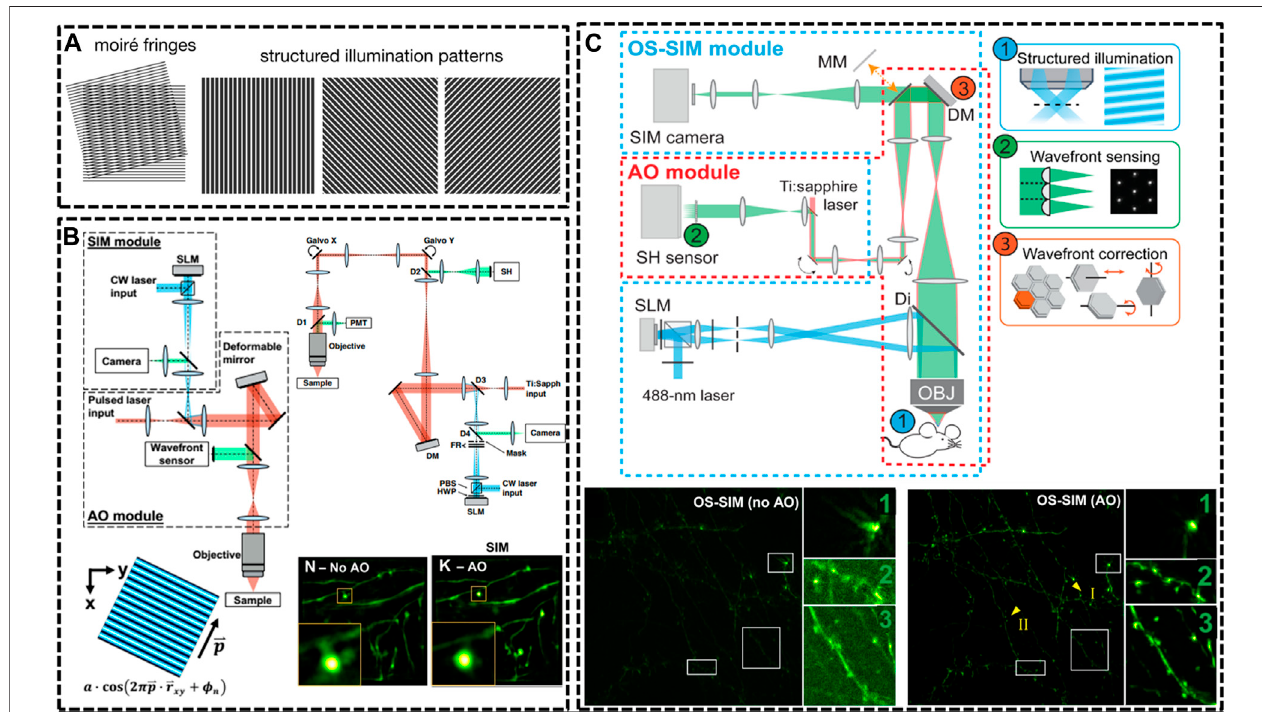
FIGURE3| SchematicofimprovedsetupsofSIMfor invivo imaging. (A) IllustrationofSIMtoresolveanunknownstructurewithaknownperiodicalpattern(Sezgin, 2017).ReprintedfromSezgin(2017)withpermissionfromIOPPublishing. (B) DetailedopticallayoutoftheSIMsetupandminimizationofaberrationsviacorrectioncollar andadaptiveoptics(AO)(Turcotteetal.,2019)ReprintedfromTurcotteetal.(2019)withpermissionfromNationalAcademyofSciencesoftheUnitedStatesofAmerica. (C) An AO module applied to optical-sectioning structured illumination microscopy (OS-SIM), which enables a marked improvement in resolution, signal, and contrast for imaging spine in mouse brain (Li et al., 2020). Scale bar, 10 μ m in original images; 3 μ m in magni fi ed box region. Reprinted from Li et al. (2020) with permission from American Association for the Advancement of